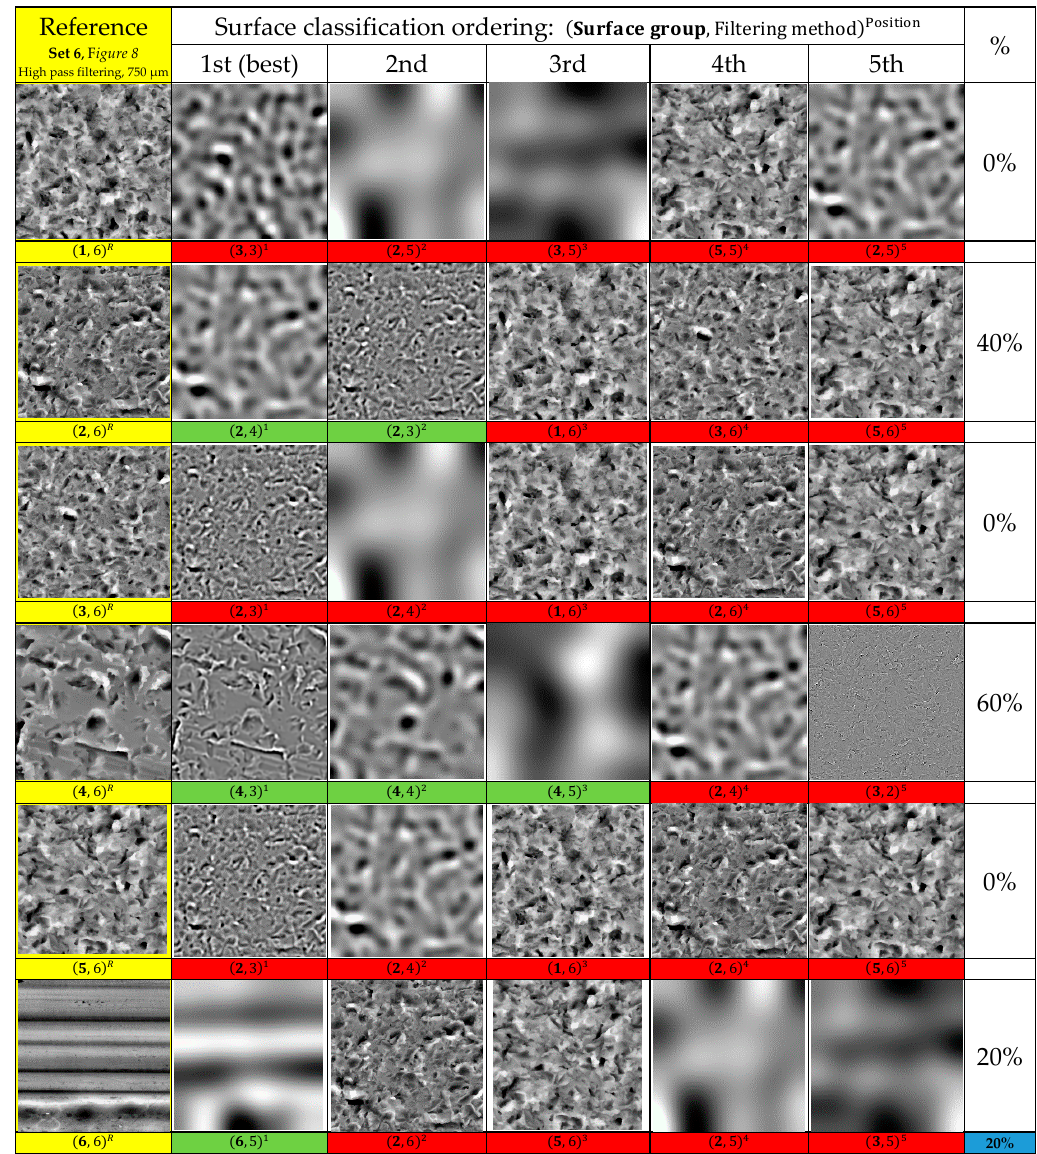
Figure 13 . First five retrieved images for six images tests (categories 1 to 6) using Intra-Prediction Modes Histogram (IPMH) which indicate a classification accuracy of 20%.